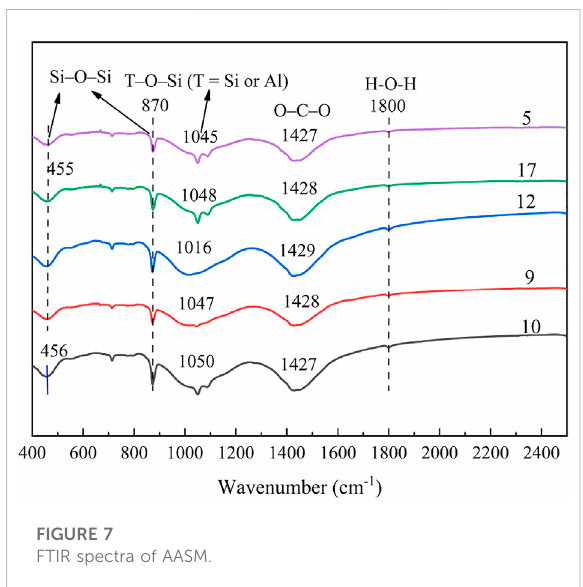
FIGURE 7 FTIR spectra of